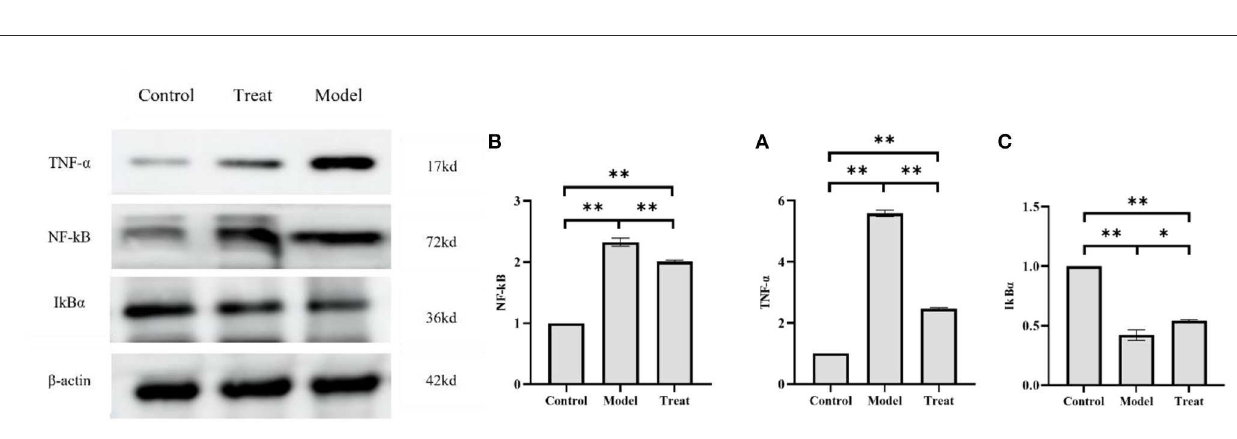
FIGURE10 Western blot results. Bar graphs show the mean results ± SD ( n = 3), (A) TNF- α ; (B) NF-kB; (C) IkB α , * P < 0.05, ** P <